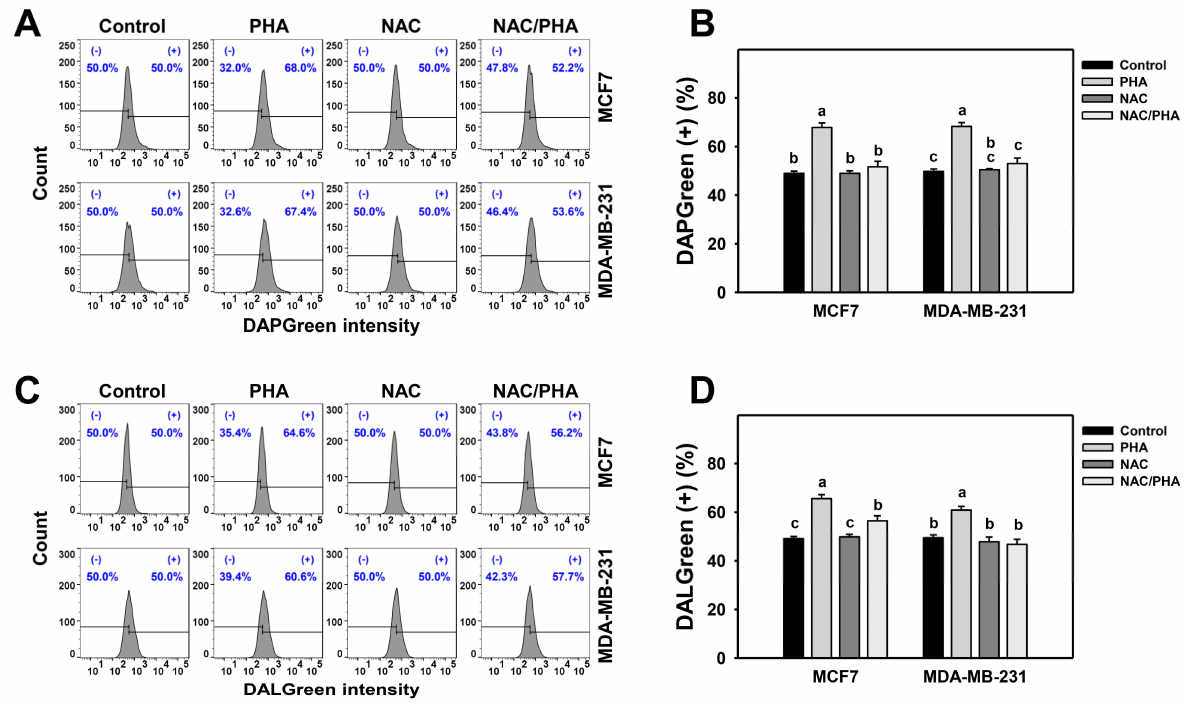
Figure 3. Inhibition of ROS decreases PHA-induced autophagy intensity in breast cancer cells. ( A , B ) Suppression of PHA-induced DAPGreen-detected autophagy by NAC. (+) indicates DAPGreen (+) (%). ( C , D ) Suppression of PHA-induced DALGreen-detected autophagy by NAC. (+) indicates DAL- Green (+) (%) Breast cancer cells (MCF7 and MDA-MB-231) were incubated with 0.1 µ M